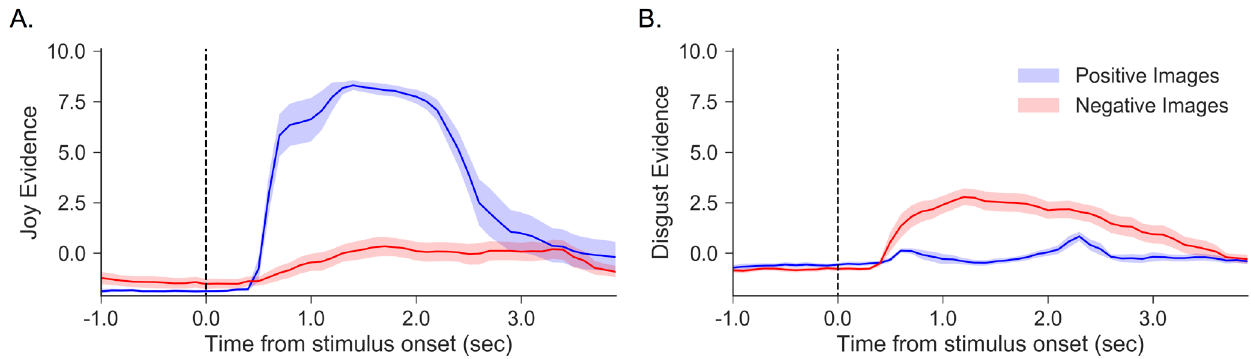
Figure 4. Different facial expressions for positive and negative images. ( A ) Evidence of smiling to positive (blue) and negative (red) images. ( B ) Evidence of disgust facial expression to positive (blue) and negative (red) images. Shaded error bars indicate standard error of the